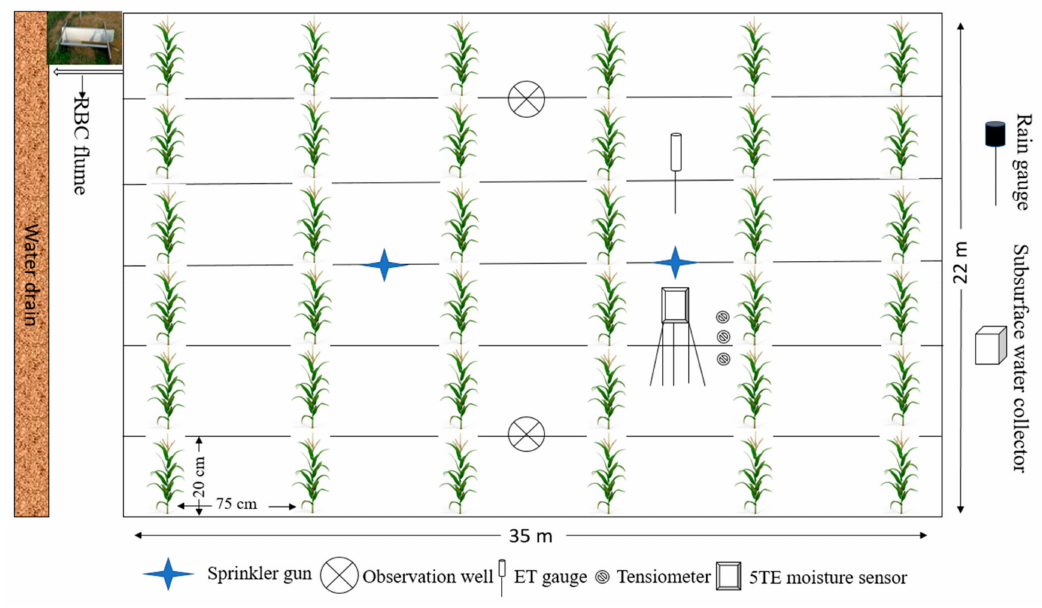
Figure 1. Field layout of equipment installed for investigation of water balance components.